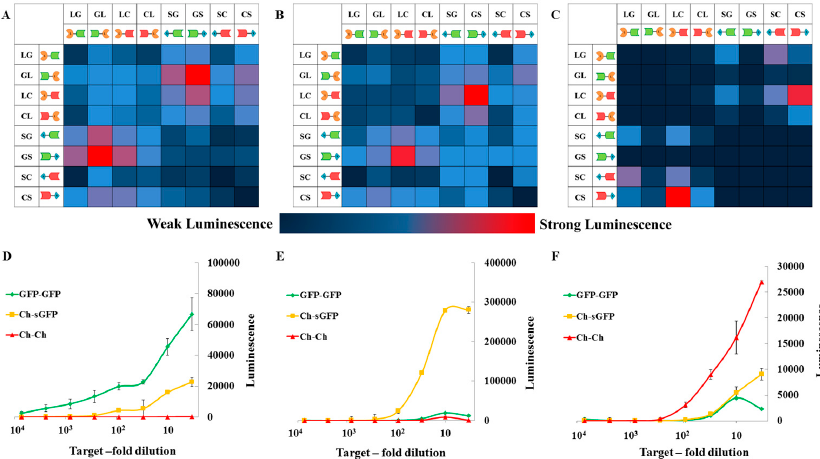
Figure 2. Heat-map and graphical representations of the selectivity of specific split-luc nanobody fusion peptide (SLN) bit pairs. ( A – C ): Heat-map representations of luminescence observed